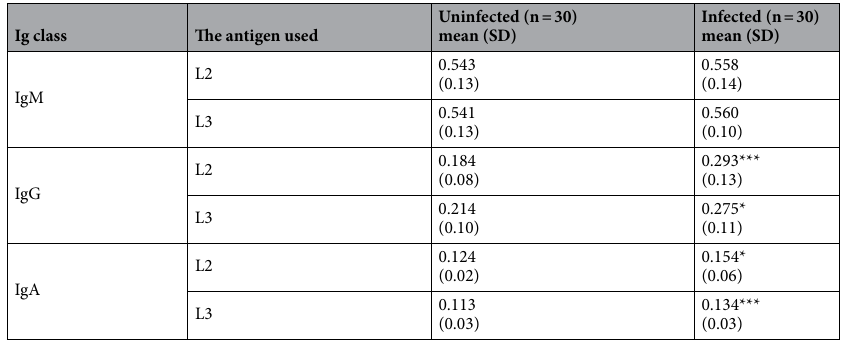
Table 1. Results of the 2nd Stage of the study: Mean reactivity (SD) of serum antibodies in classes IgG, IgM and IgA in the horses free from invasion and infected ones (> 50 larvae) with antigens isolated from L2 and L3 G. intestinalis in the ELISA test (A = 492 nm). Legend: L2—larval stage II, L3—larval stage III, statistical significance: * p ≤ 0.05, ** p ≤ 0.01, *** p ≤ 0.001, in comparison with the horses free from invasion.